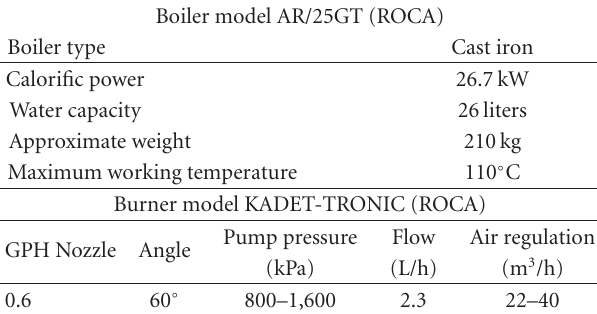
Table 5: Characteristics of the generating equipment used in the combustion